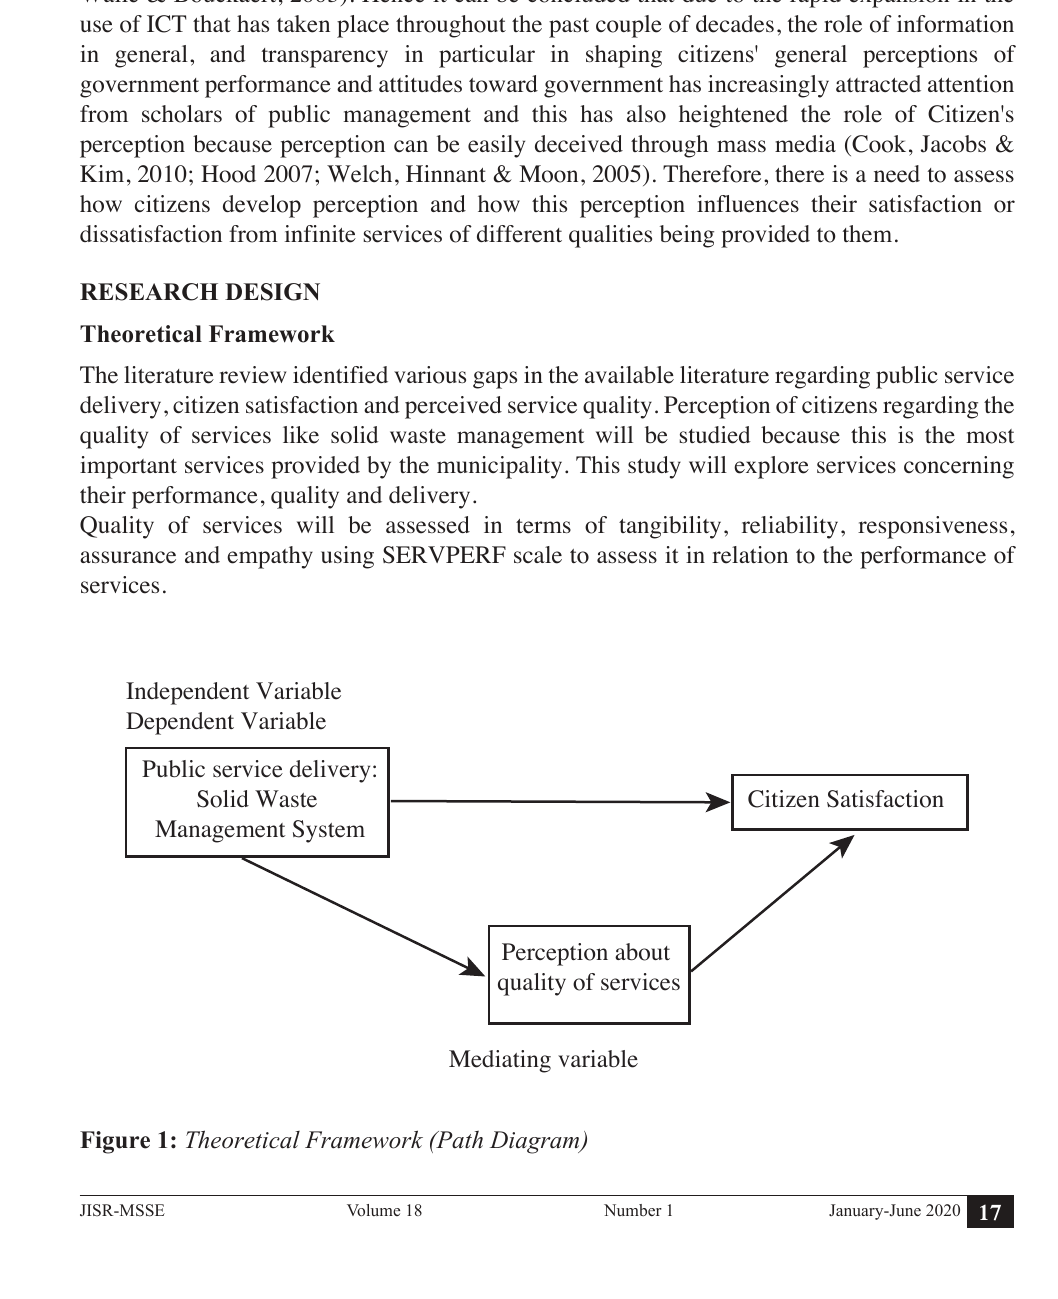
Mediating variable